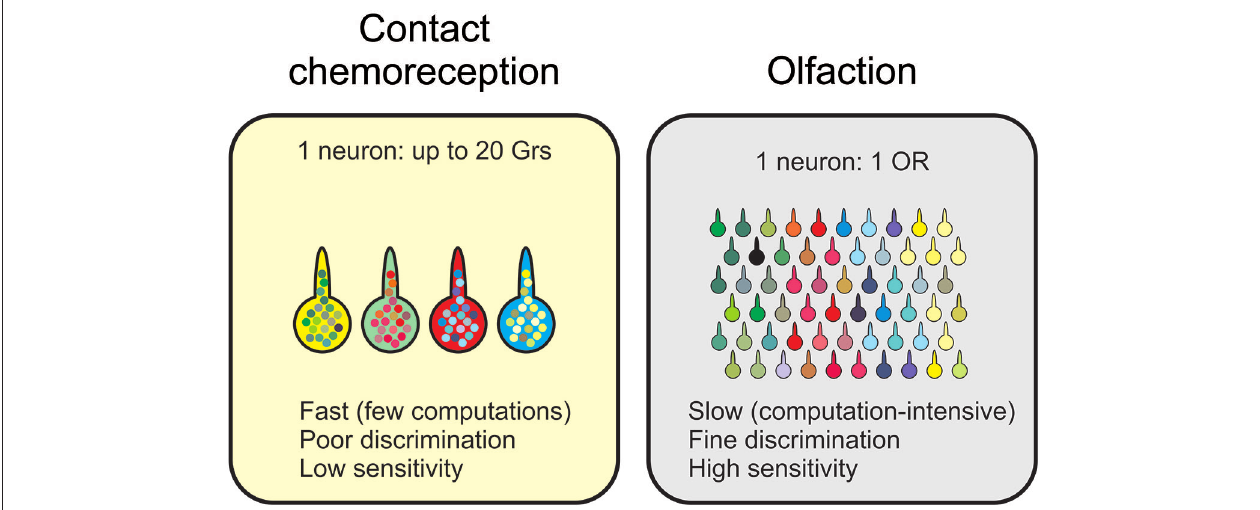
FIGURE 5 | Fundamental differences between olfaction and contact chemoreception in insects. Although taste and olfactory sensilla have similar cellular compositions, the wiring of the neurons to the central nervous system and the number of different receptors expressed in each neuron is very different. These differences certainly impact the discriminative power and the speed at which information is